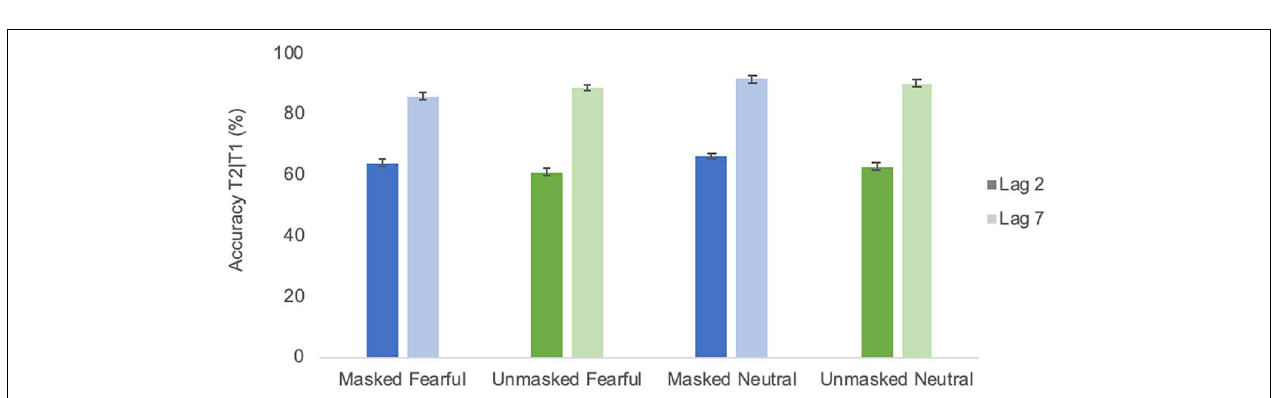
FIGURE 2 | Schematic illustration of the experimental design in all experiments.